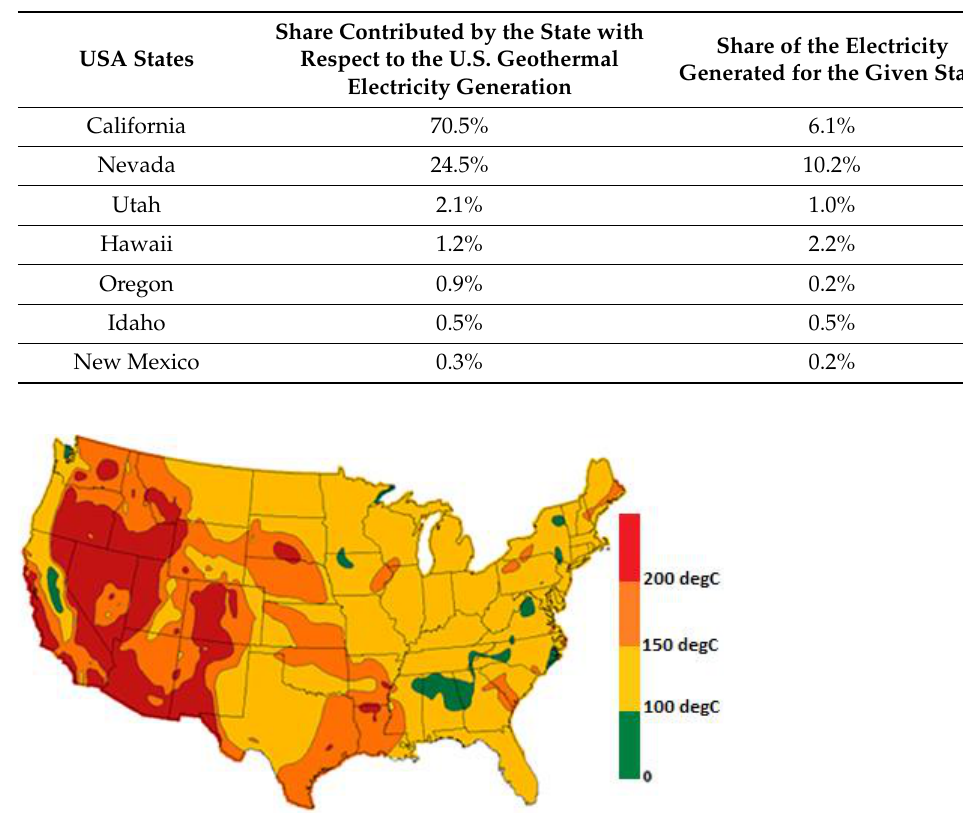
Figure 7. Distribution of geothermal resources in the US [35].